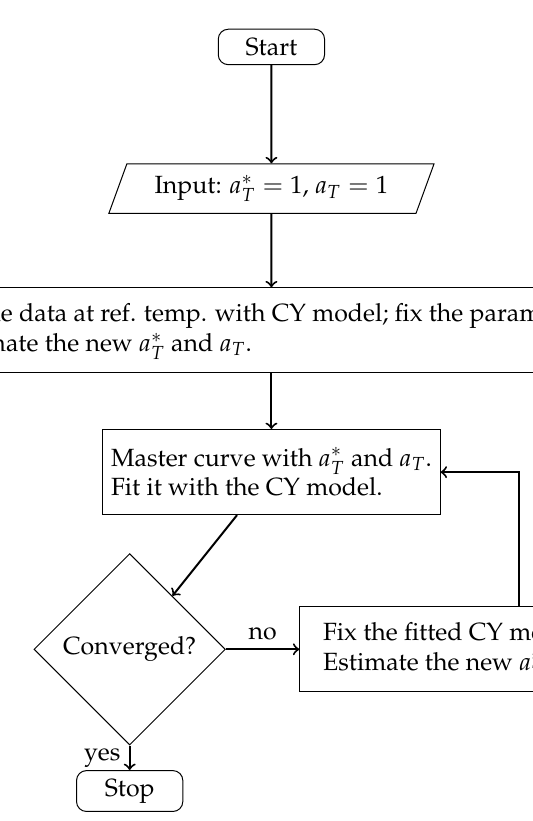
Figure 2. Scenario 2